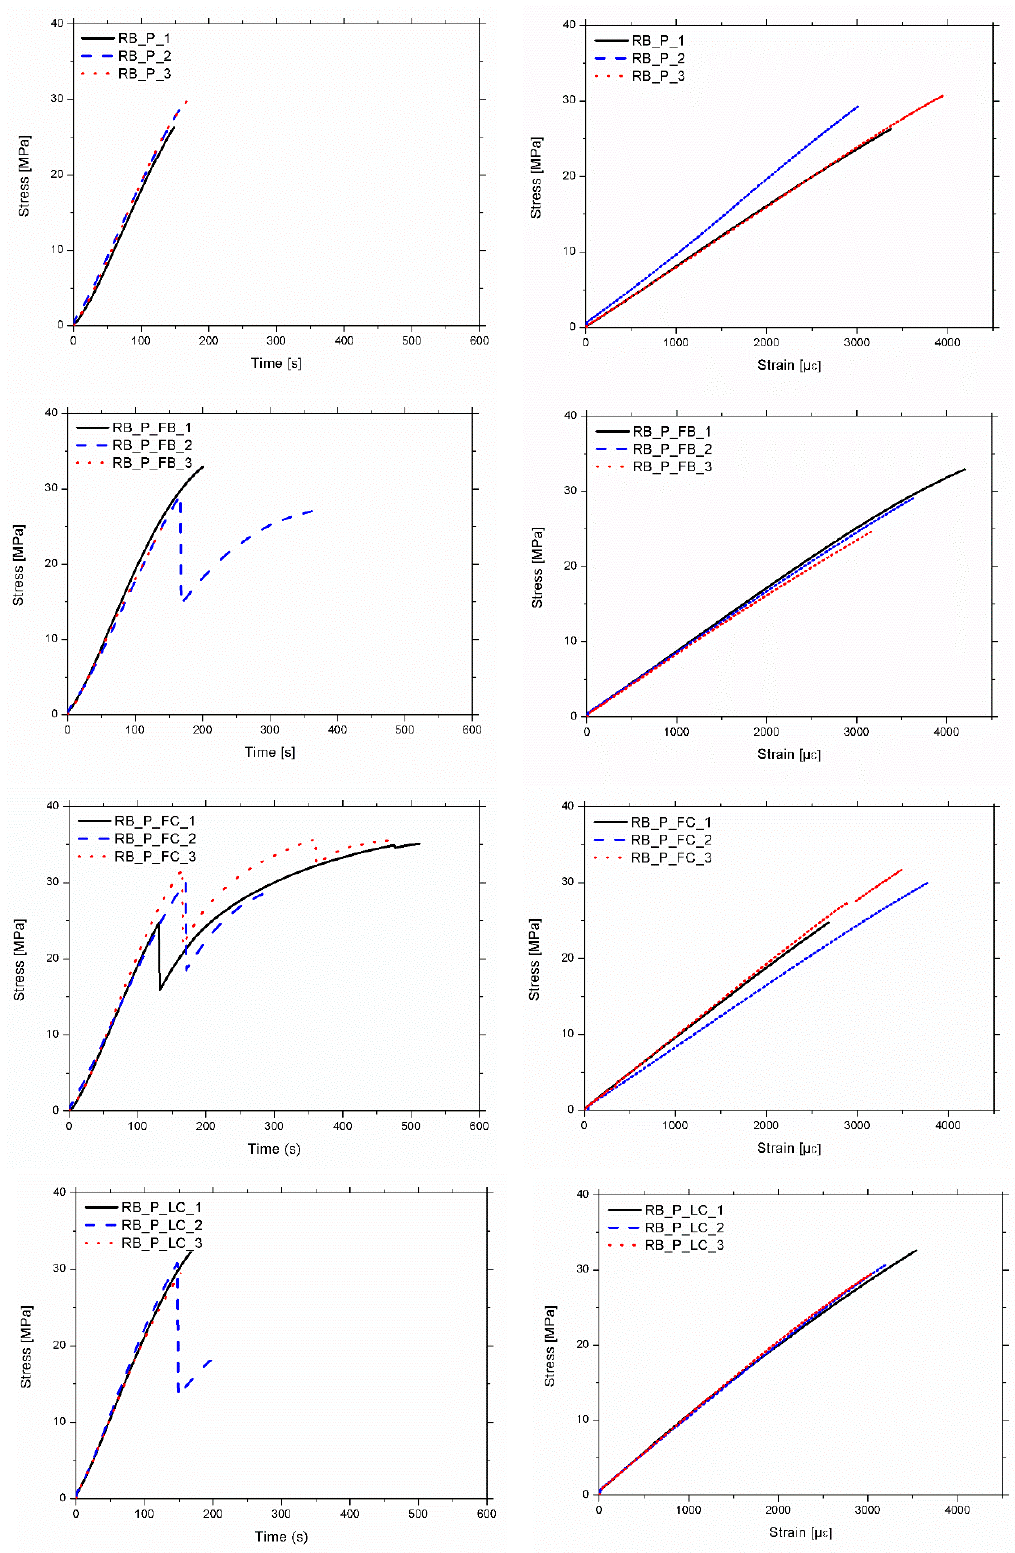
Figure 6. ( Left ) Stress–time plots. ( Right ) Stress–strain plots. Table 3. Mechanical results for the 12 tested specimens.